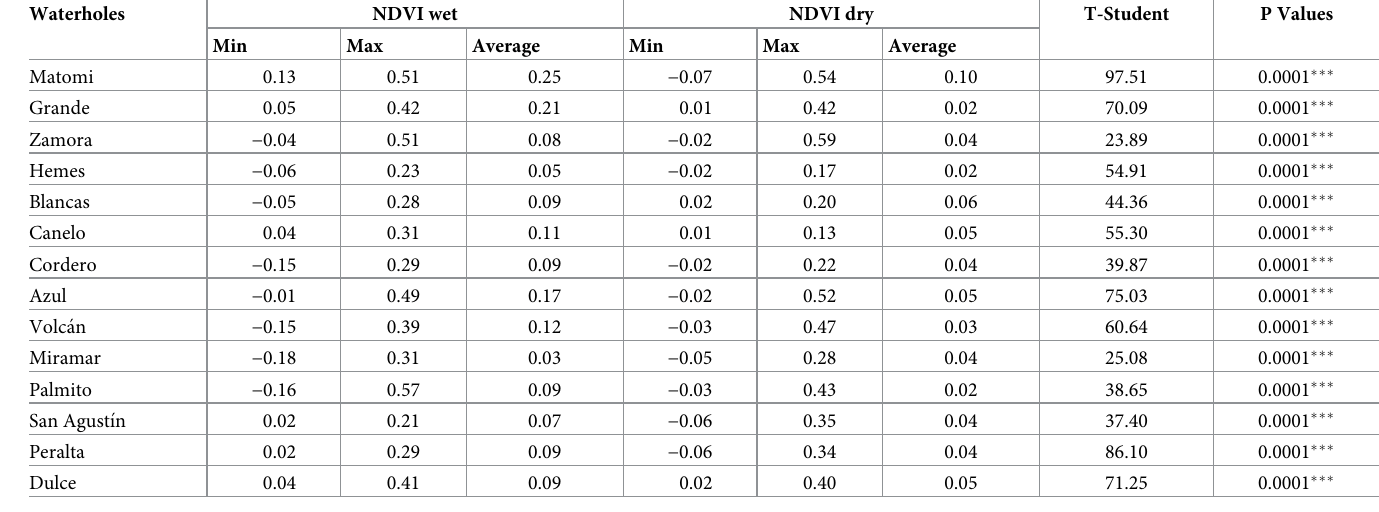
Table 2. Comparison of seasonal (wet = November to February; dry = May to July) NDVI, minimum and maximum value of pixel around the edge of the waterhole using paired t-test at waterholes detected in Sierra Santa Isabel, Baja California, Mexico.